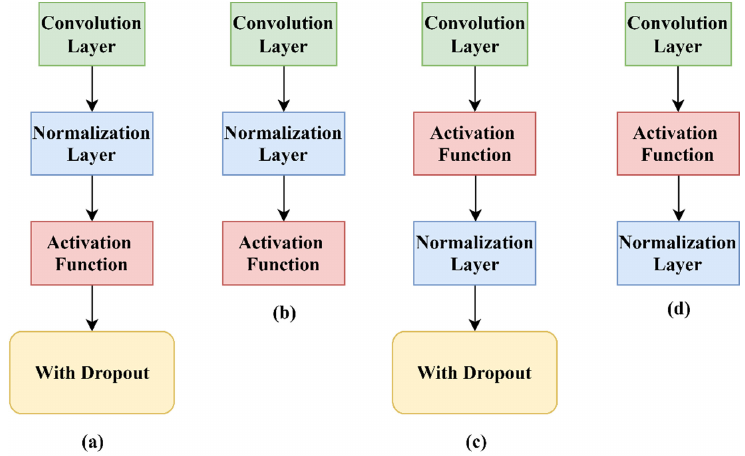
Figure 2. Different designs tested: ( a ) shows the first design, the proposed architecture with the normalization layer placed before the activation function, and two dropout layers are placed in the classifier block; ( b ) shows the second design, which is similar to the first design but without any dropout layers; ( c ) shows the third design, where the normalization layers are placed after the activation function, and two dropout layers are placed in the classifier block; and ( d ) shows the fourth design, which is similar to the third design but without any dropout layers.